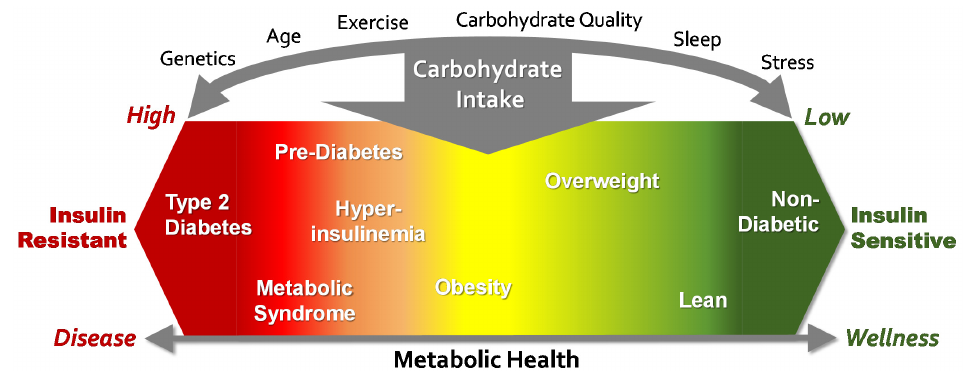
Figure 1. Expression of an insulin resistant or sensitive phenotype is a continuum that is strongly influenced by carbohydrate intake, with modulation based on genetic predisposition, age, and lifestyle choices.